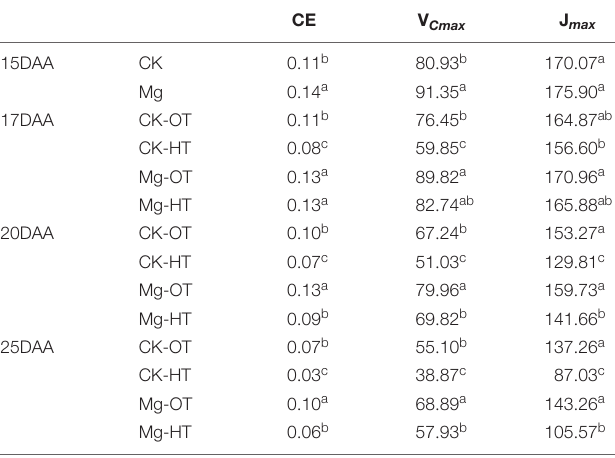
Means were compared using Duncan’s multiple-comparison tests. Different lowercase letters after data in the same column indicate significant variations within the same year at P <